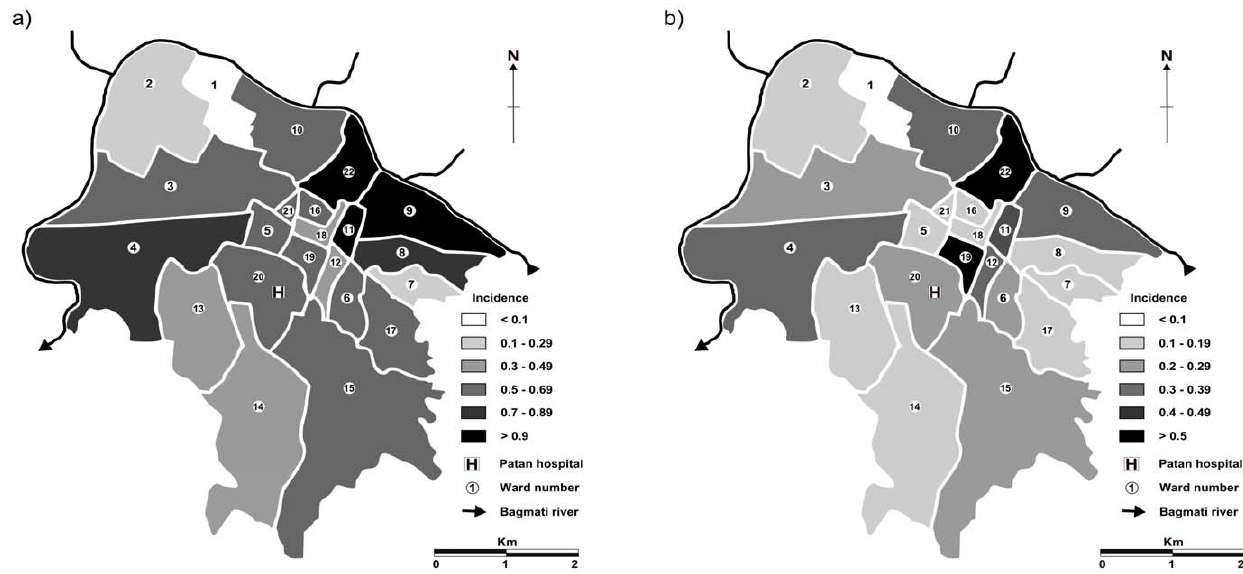
Figure 3. The distribution of enteric fever cases in LSMC. Maps depicting the average annual incidence of enteric fever per 1,000 population in the 22 wards (numbered) that constitute the Lalitpur Sub-Metropolitan City (LSMC), based on enteric fever cases enrolled in clinical trials at Patan Hospital between June 2005 and May 2009 for (a) S . Typhi and b) S . Paratyphi A). Patan Hospital is located in ward 20 and is highlighted. Ward population figures are presented in Table